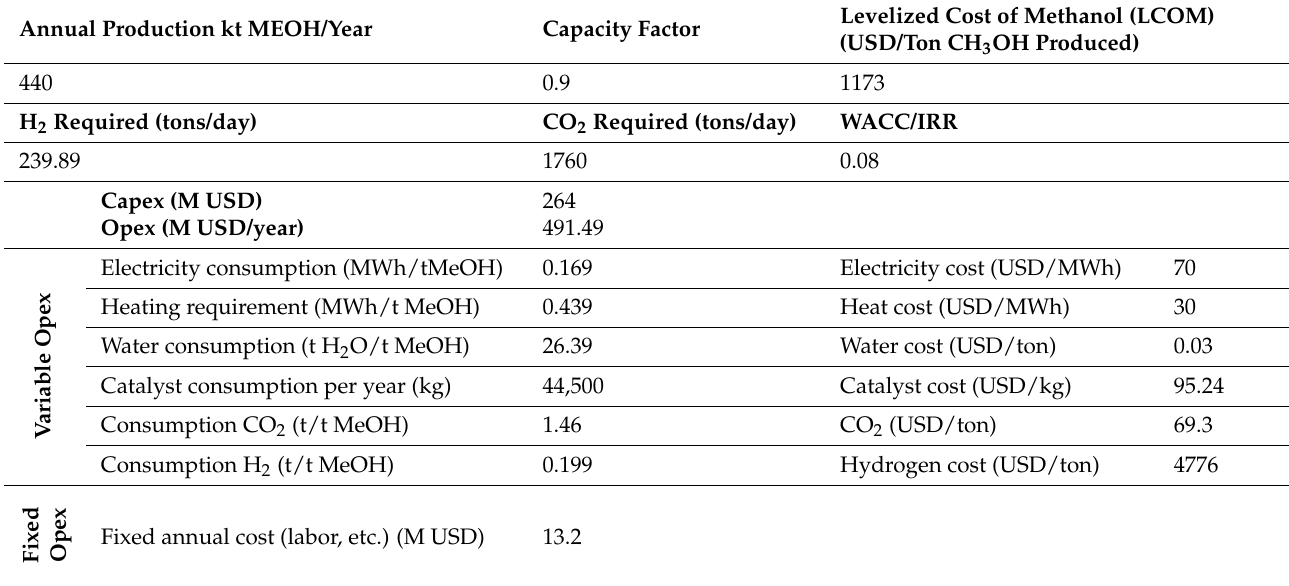
Table 3. Cost input for methanol production from